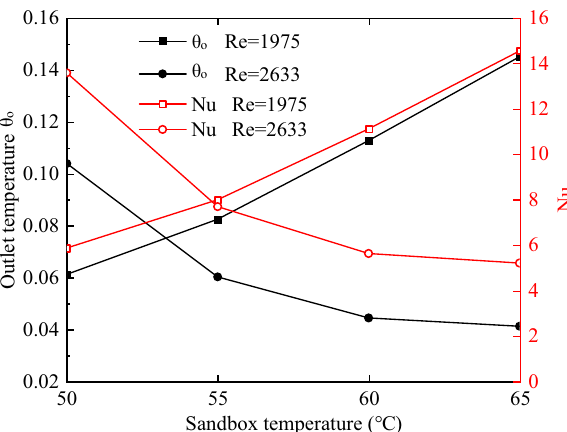
Fig. 17 The variation of average outlet temperature and Nu with the initial temperature of sandbox in forward flow mode